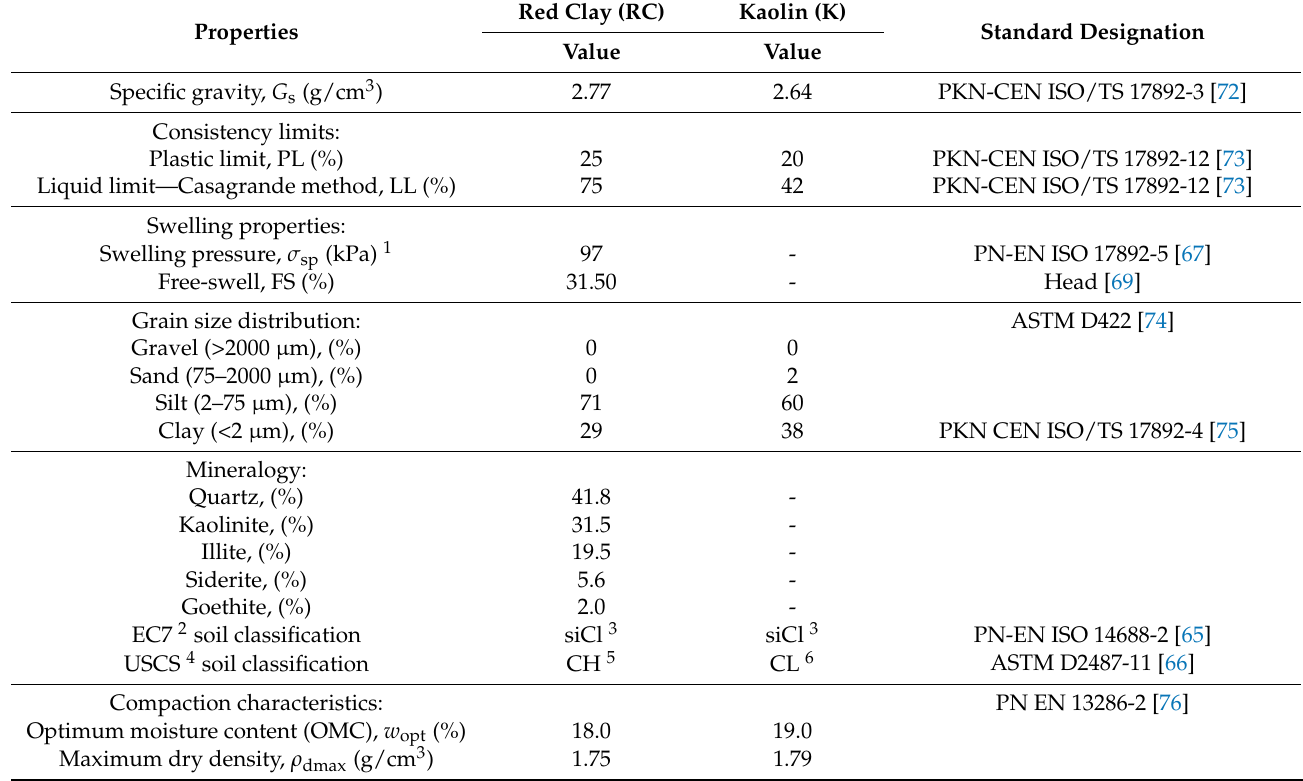
Table 2. Basic geotechnical properties of red clay (siCl/CH) and kaolin (siCl/CL)